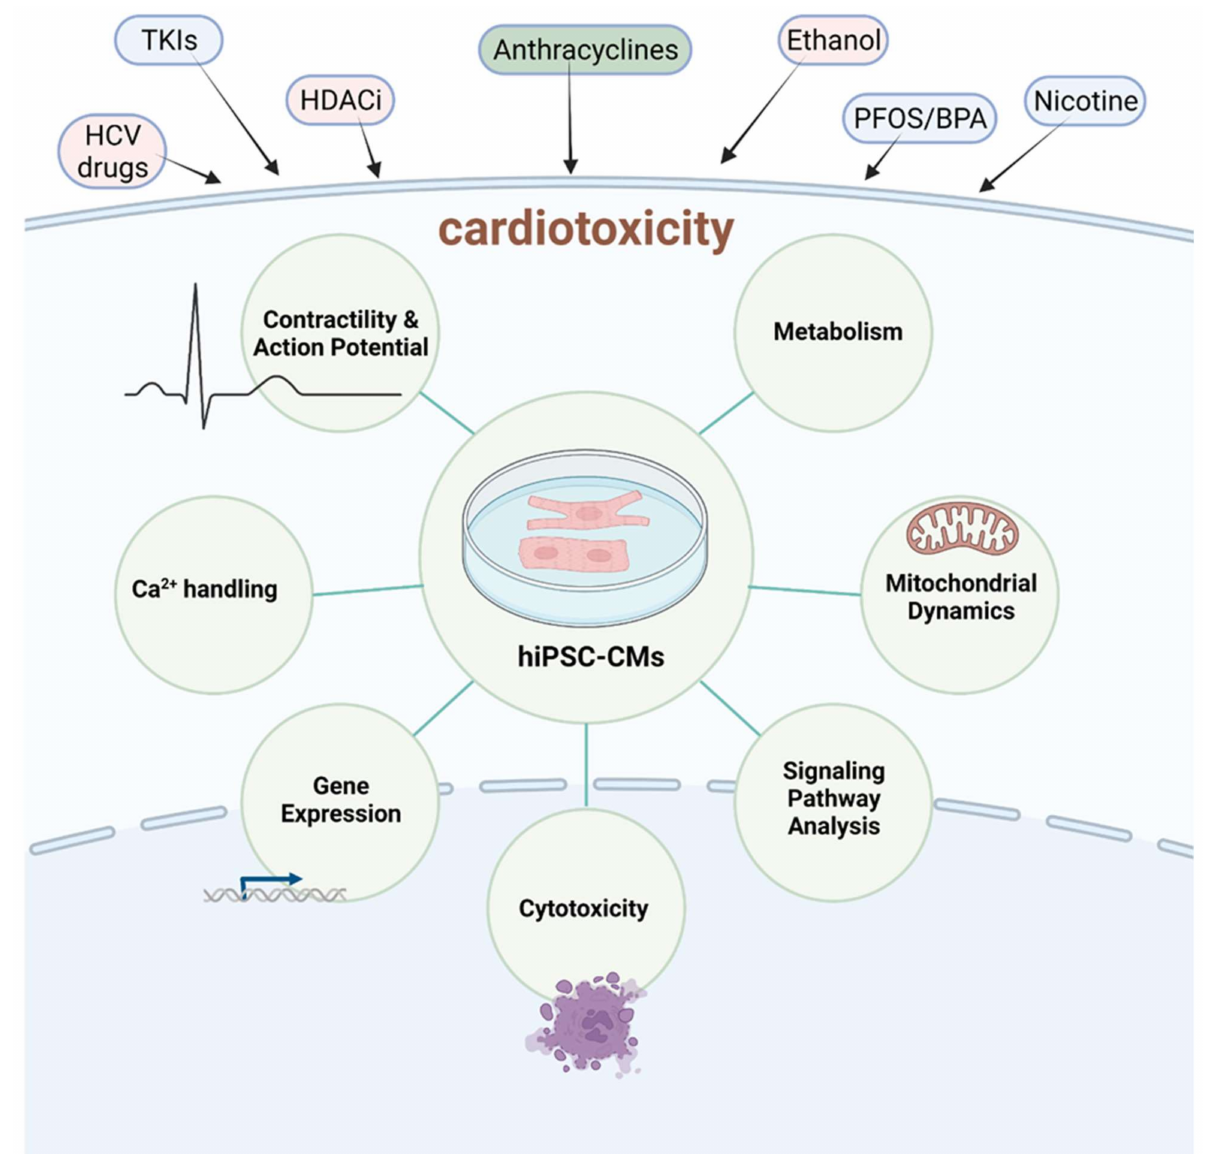
Figure 2. Potential cardiotoxicity mechanisms and chronic assay